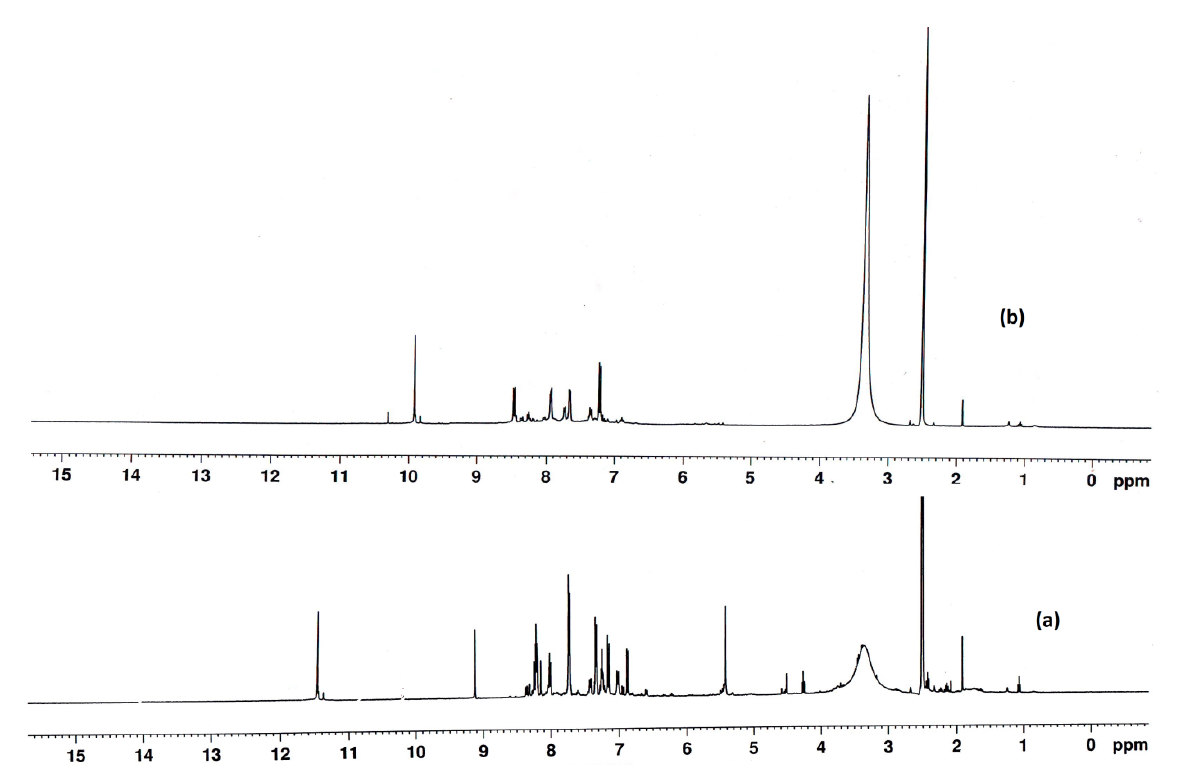
Table 2. 1 H NMR data for Schiff base ligand and its nano-complex. Compd. No.